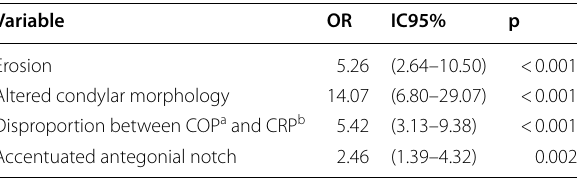
Table 4 Logistic regression of the variables assessed on the panoramic radiograph of patients with juvenile